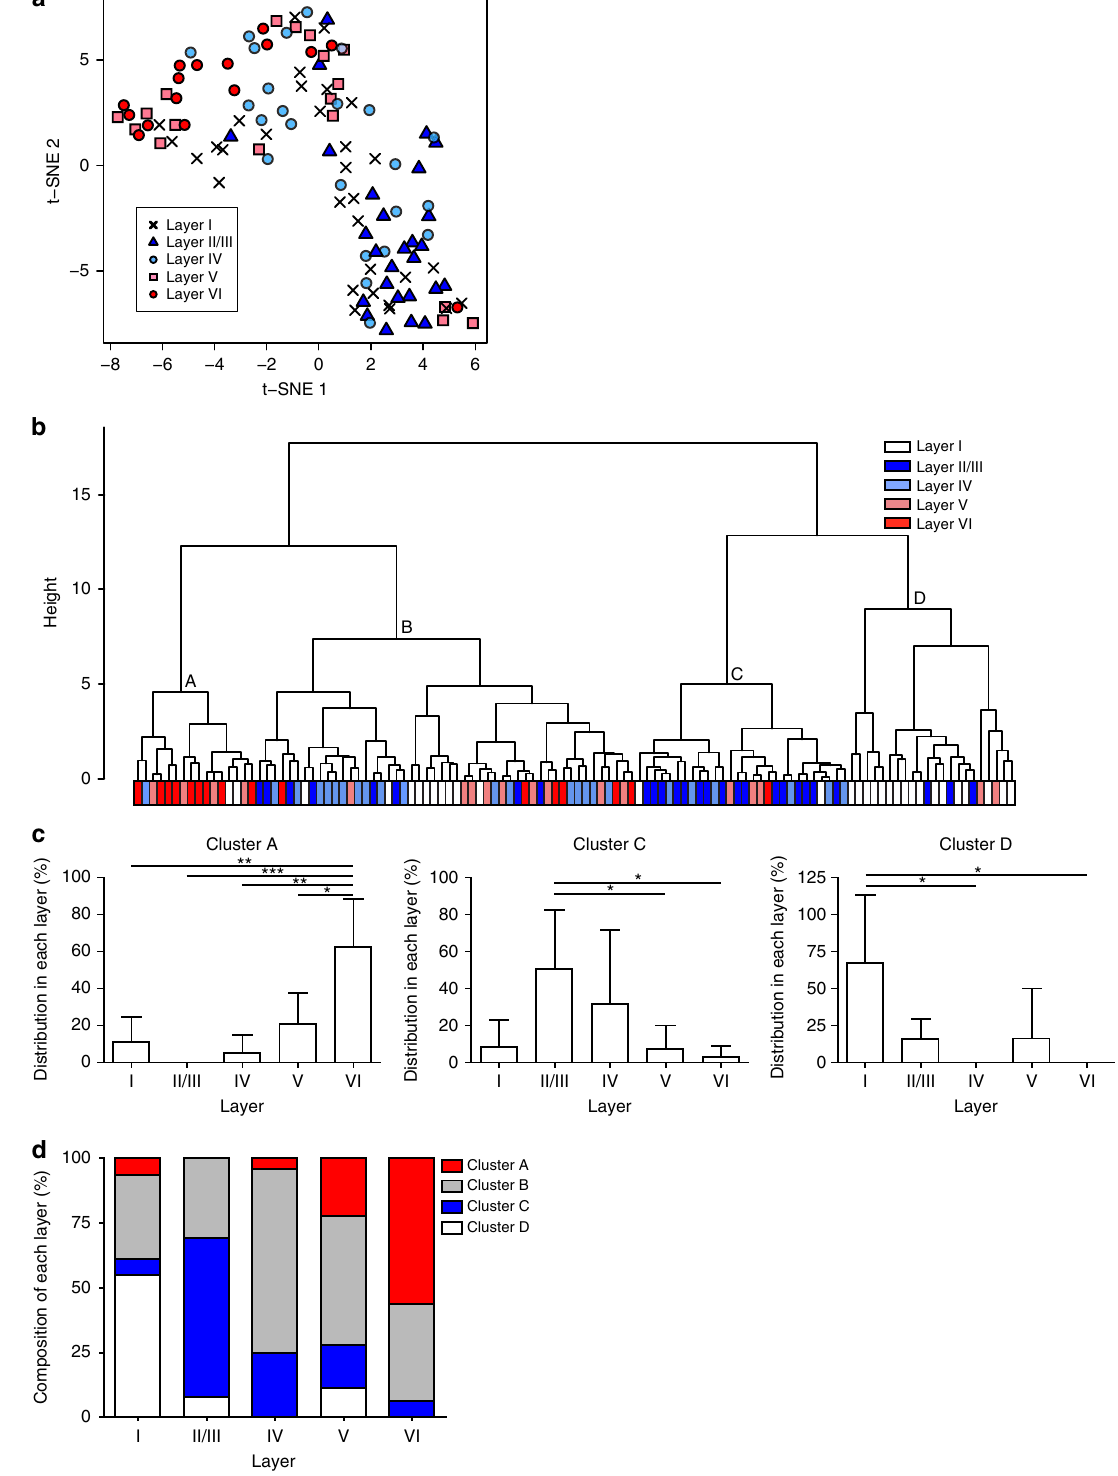
Fig. 2 Cluster analysis based on morphological features of neocortical astrocytes. a t-SNE analysis showing separation of neocortical astrocytes into two groups, with most cells in layer II/III and those in layers V and VI localizing to different groups. b Hierarchical clustering showing that neocortical astrocytes can be separated into four clusters designated A through D, with cluster A being enriched in astrocytes of layers V and VI, cluster C in those of layer II/III, and cluster D in those of layer I. c Percentage of astrocytes in each cluster located in the different neocortical layers (cluster A, n = 16; cluster C, n = 28; cluster D, n = 22). Data are means± s.d. for at least three mice. * P < 0.05, ** P < 0.01, *** P < 0.001 (one-way ANOVA followed by Bonferroni ’ s test). d Percentage of astrocytes in each layer belonging to clusters A through D (layer I, n = 31; layer II/III, n = 27; layer IV, n = 24; layer V, n = 18; layer VI, n = 16). Two-sided Fisher ’ s exact test, P = 8.439 × 10 −